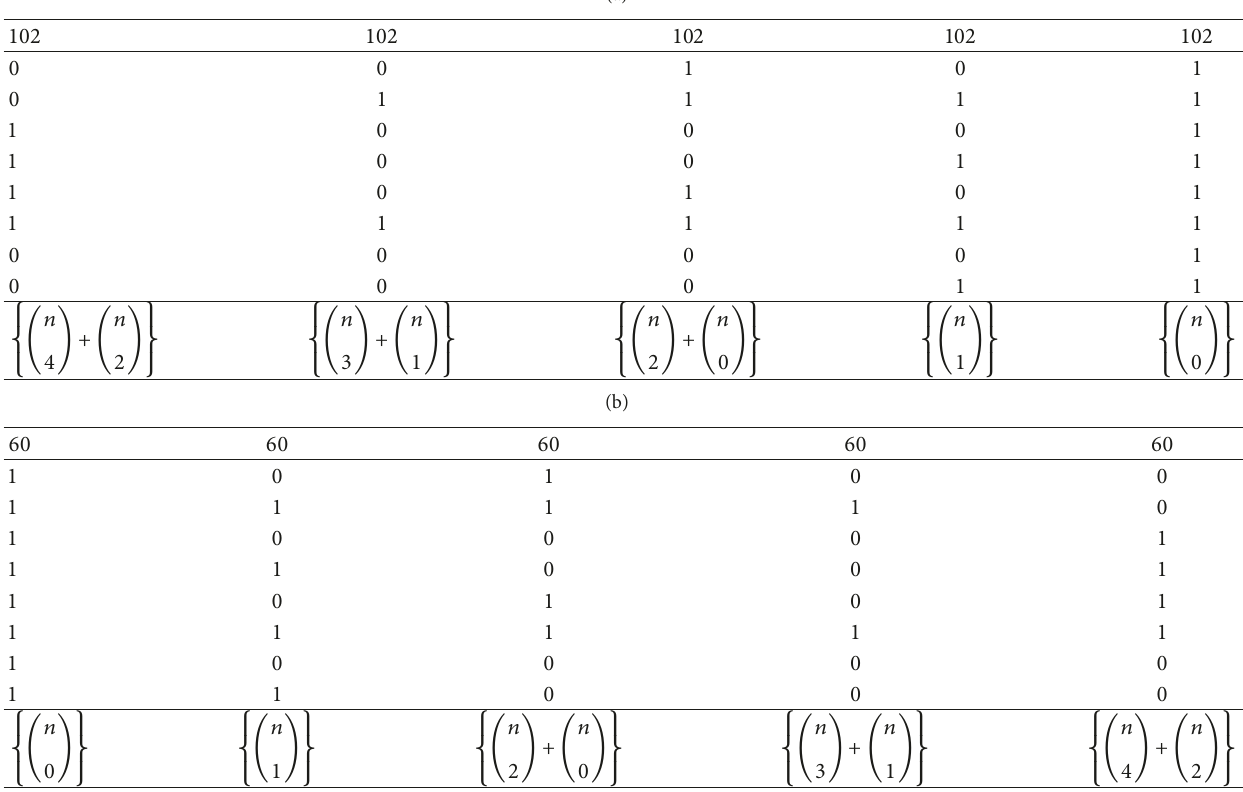
Table 4: Examples of 102-CA and 60-CA and the binomial representation of the generated vertical sequences.